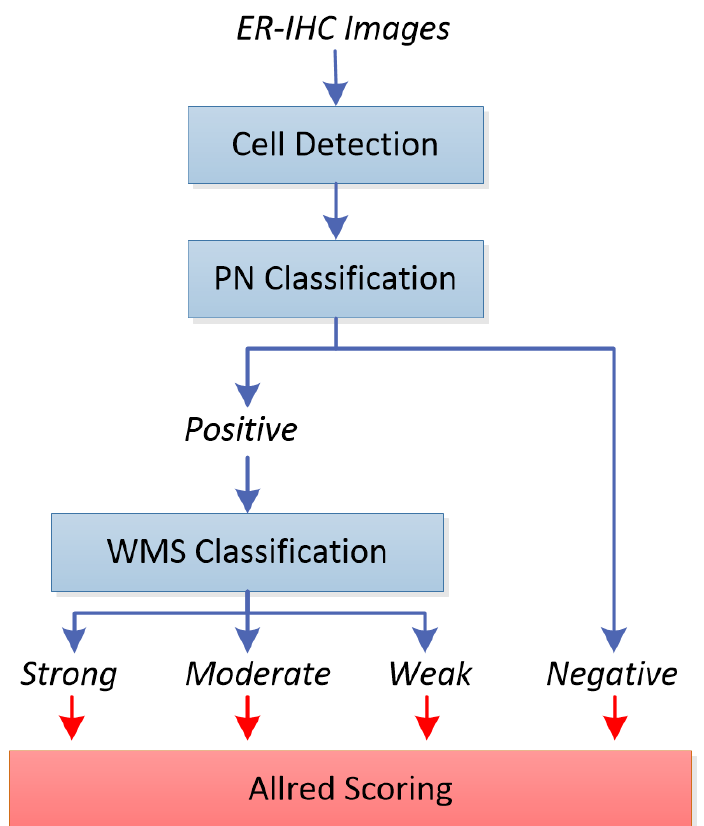
Figure 1. Flowchart for the overview of the